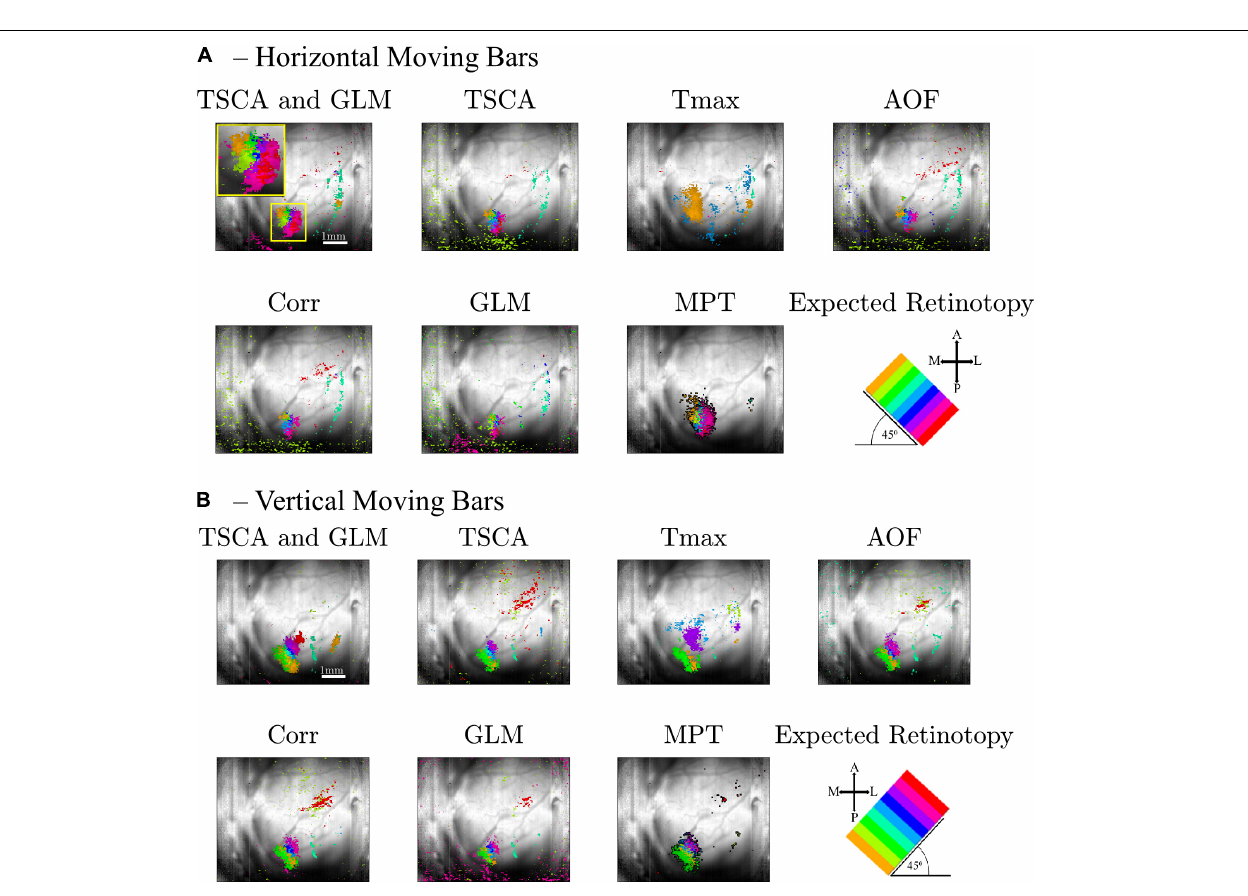
FIGURE 7 | Retinotopic maps generated by the seven methods following a VSDI recording of cortical responses to high-resolution retinal stimuli of a 9-location moving ( A , horizontal, B , vertical) bar. Only pixels with score values above the 90th percentile of all the pixels’ maximum scores are presented. The scale bar shown in the top left panel is 1 mm. The cortical orientations are seen in the bottom right figure, along with the expected cortical response (A, anterior; P, posterior; M, medial, and L, lateral). Each color (hue) represents the cortical response location of the matched retinal stimuli.